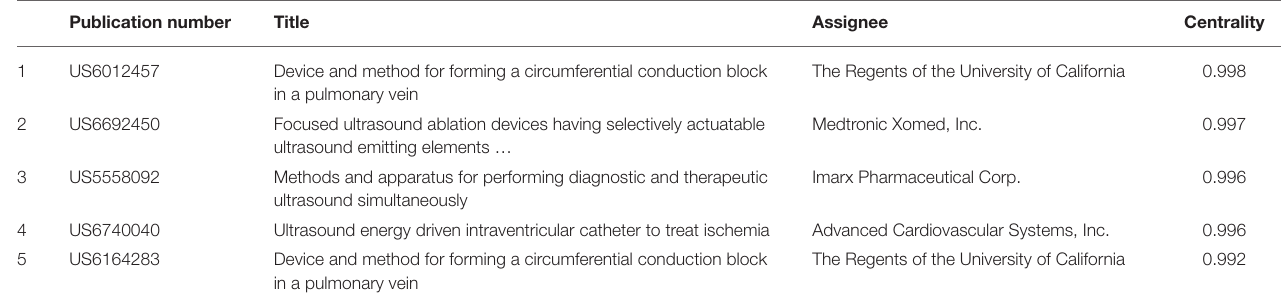
TABLE 12 | Top five central patents for the ultrasound energy-based therapeutic technological domain with their assignees and centrality values.